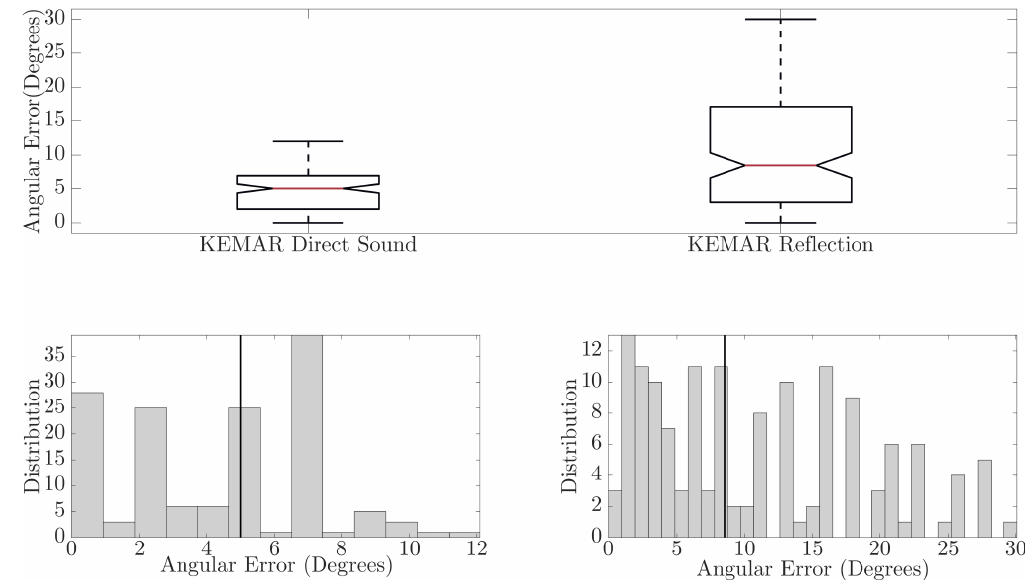
Figure 6. Comparison of angular errors in the neural network direction of arrival predictions for measurements with the KEMAR 45BC. The top image is a boxplot comparison of the angular error in the neural network predictions for the direct sound and reflected components. The bottom left is a histogram showing the error distribution for the direction of arrival predictions of the direct sound, and the bottom right is the error distribution for the direction of arrival predictions of the reflected components. The black line on the histograms depicts the median angular